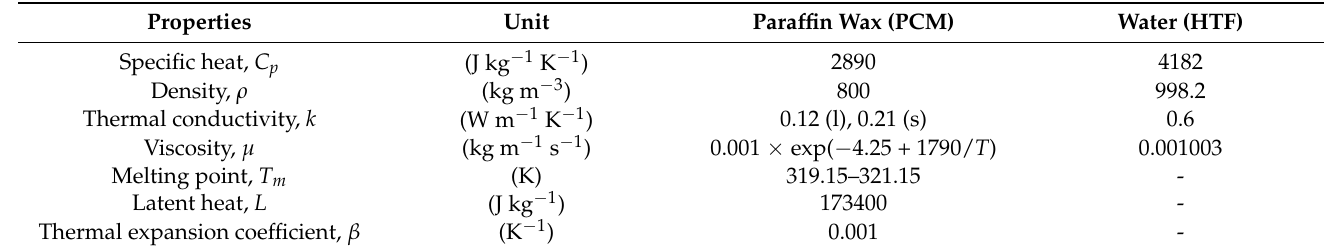
Table 3. Thermophysical properties of PCM and HTF